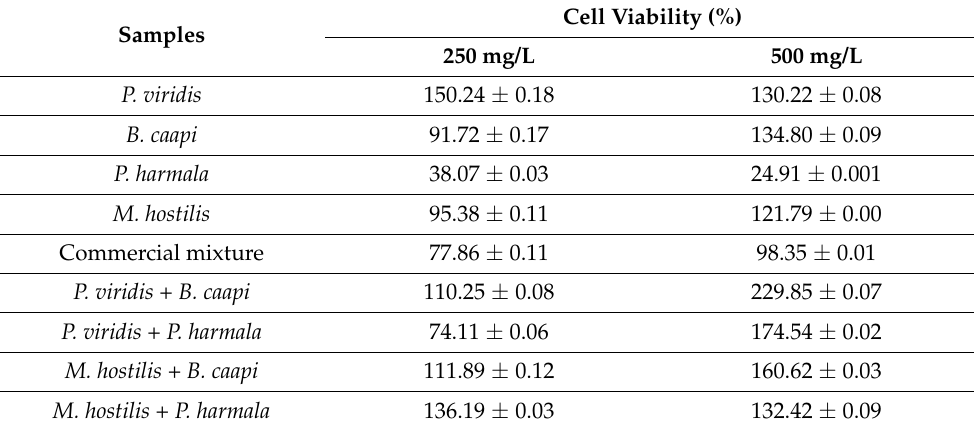
Table 1. Cell viability after exposure to extracts. The values are expressed as mean ±